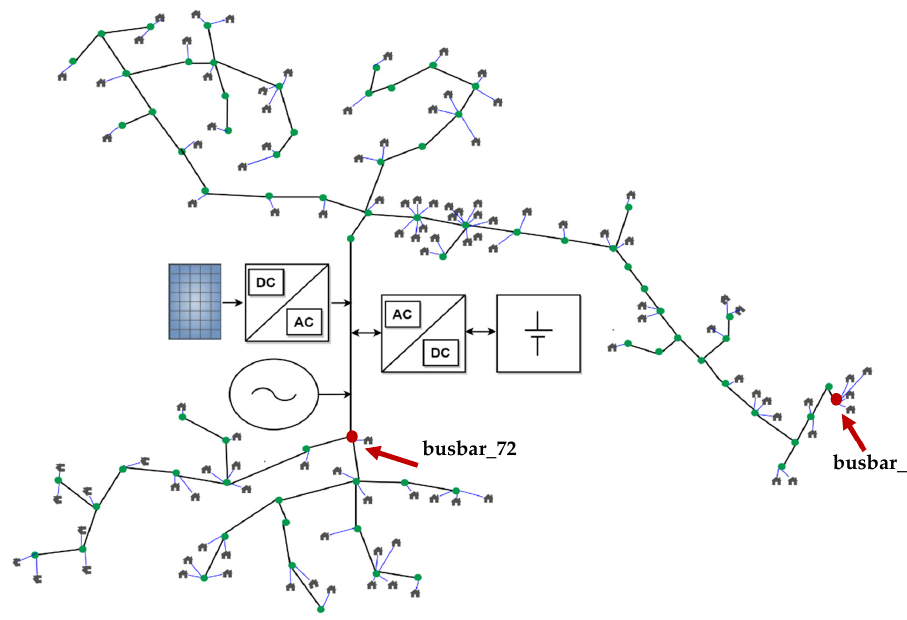
Figure 6. OpenDSS hybrid mini-grid layout.